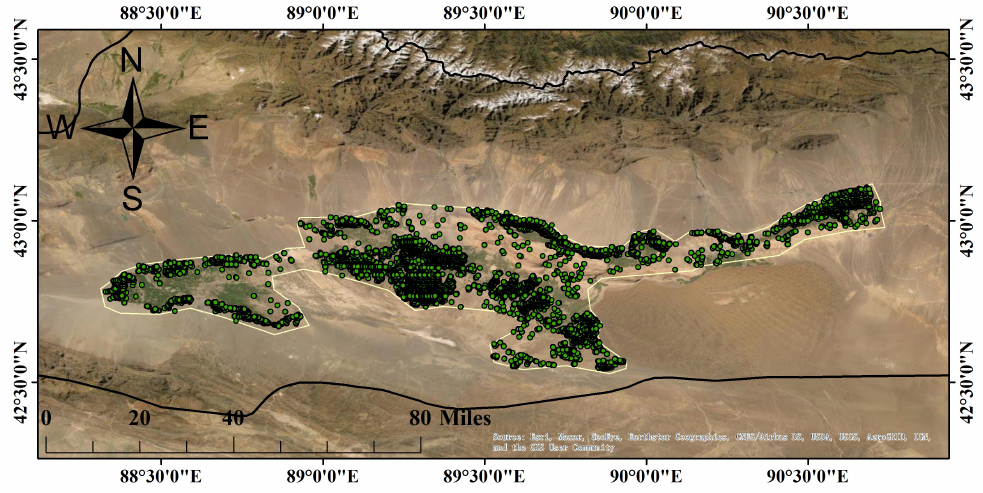
Figure 13. Distribution map of shafts after removing the misidentified karez according to the boundary line of the karez. The solid green points represent the shafts within the range line of the Karez in Turpan, and are the final result of the shafts in this paper. Each shaft are represented by solid green points with black boundaries. After the dense green points overlap, the color may appear black. The base map is World-Imagery in